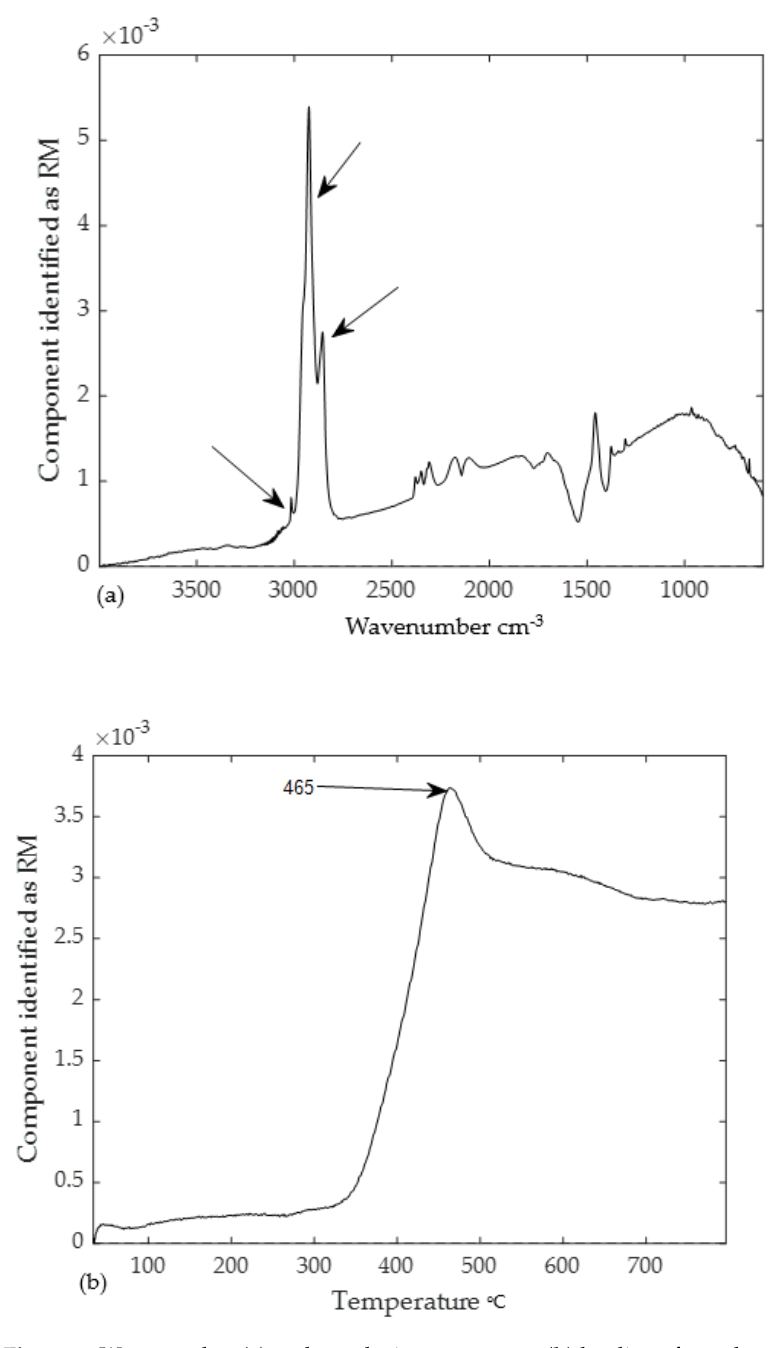
Figure 2. Wavenumber ( a ) and pyrolysis temperature ( b ) loadings from the rubber materials (RM) component in the PARAFAC model. Peaks supporting the identification of RM are indicated with arrows on the graphs.